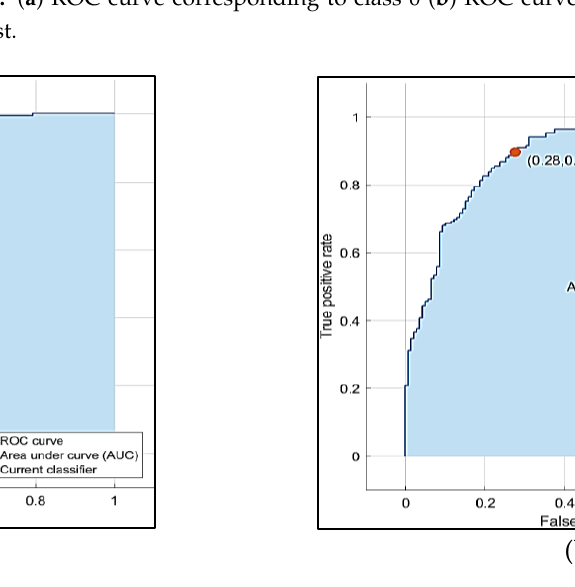
( b ) Figure 11. ( a ) ROC curve corresponding to class 0 using the KNN ( b ) ROC curve corresponding to class 1 using the KNN. The KNN model has a false positive rate (FPR) of 0.18, indicating that the model mis- takenly allocated 18% of the data to the positive class, and a true positive rate (TPR) of 0.69, indicating that the model properly assigned 69 percent of the observations to the positive class. The AUC for the KNN Model is 0.75. Figures 12a,b, 13a,b, and 14a,b exhibit the ROC curve values for the bagged trees, LR, and the Gaussian naive Bayes. The AUC curve of the bagged tree is 0.88, but the AUC curves of the LR and the Gaussian naive Bayes are both 0.89.